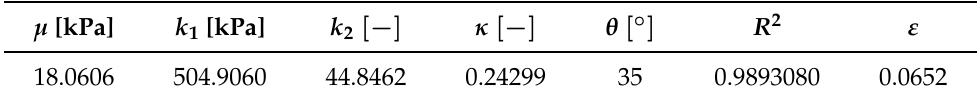
Table 2. Material parameters obtained from the uniaxial stress-stretch curves. Constants µ and k 1 in kPa, θ in degrees, k 2 , κ and ε dimensionless.